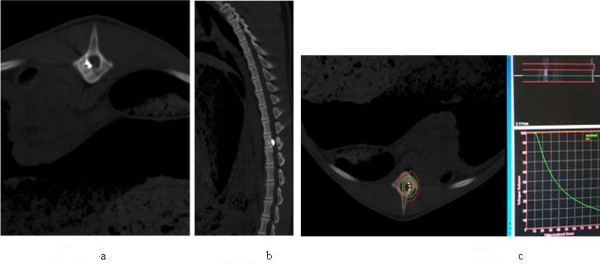
A) and B) are CT scanning to confirm the location of seeds in T13 level of swine spine; C) is typical isodose and seeds distribution displayed in the cross section CT slices for some individual pig obtained by TPS system.